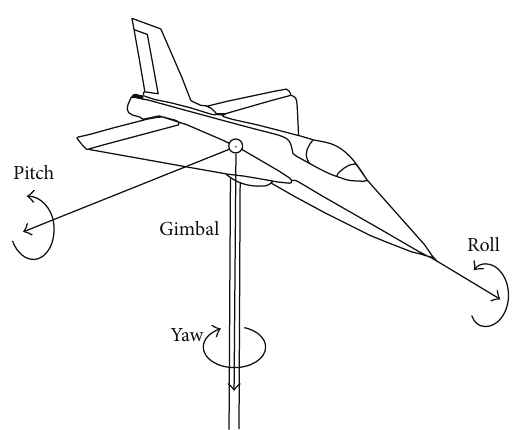
Figure 24: 3-DOF rig used for achieving Dynamic Wind Tunnel Simulation in NAL [116].